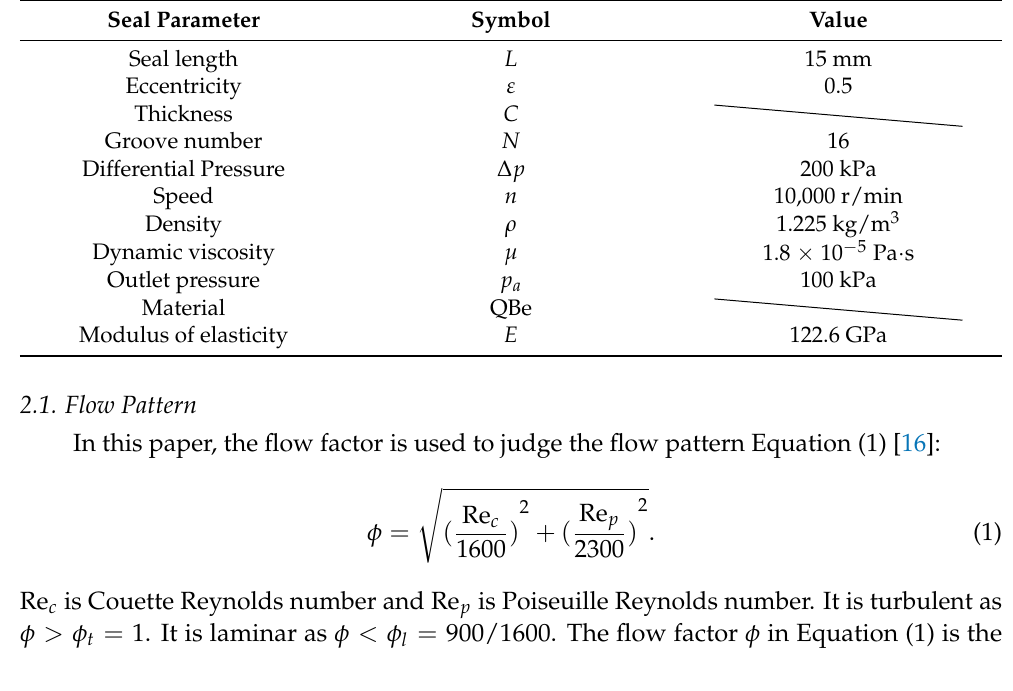
Table 1. The parameters of compliant foil gas